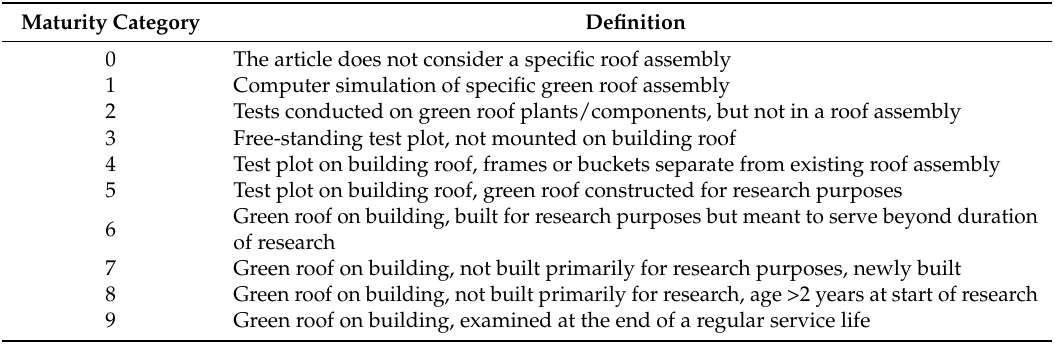
Table 2. Categorization of roof maturity categories in researched